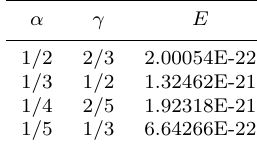
Table 1. Errors for the least squares method, n = 5.